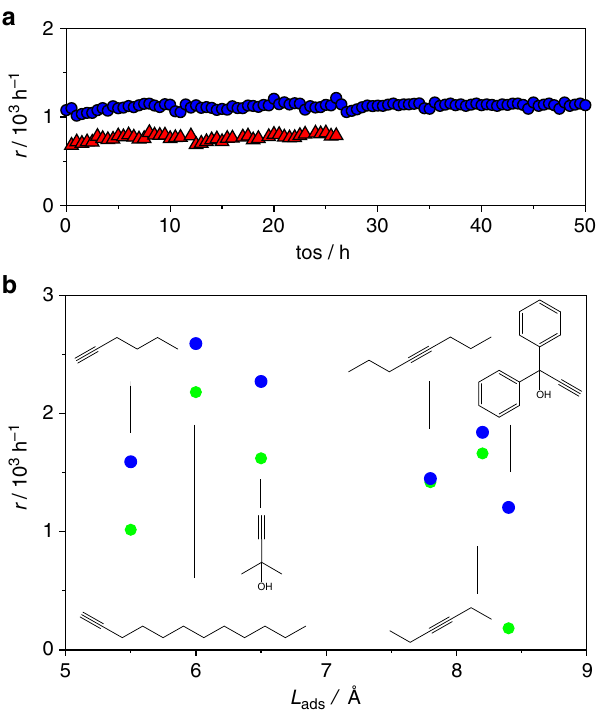
Fig. 6 Stability and substrate scope of the palladium sul fi de catalysts. a Both Pd 3 S/C 3 N 4 (blue circles) and Pd 4 S/CNF (red triangles) display a stable performance on stream in the selective hydrogenation of 2-methyl- 3-butyn-2-ol. b The impact of the adsorption length ( L ads ) of functionalized alkynes of different sizes over Pd 3 S/C 3 N 4 -423 (blue circles) and Pd- HHDMA (green circles). Conditions: W cat = 0.1 g, T = 303 K, P = 1 ( a ) or 3 ( b ) bar, F L (alkyne + toluene) = 1 cm 3 min – 1 , F G (H 2 ) = 36 cm 3 min − 1